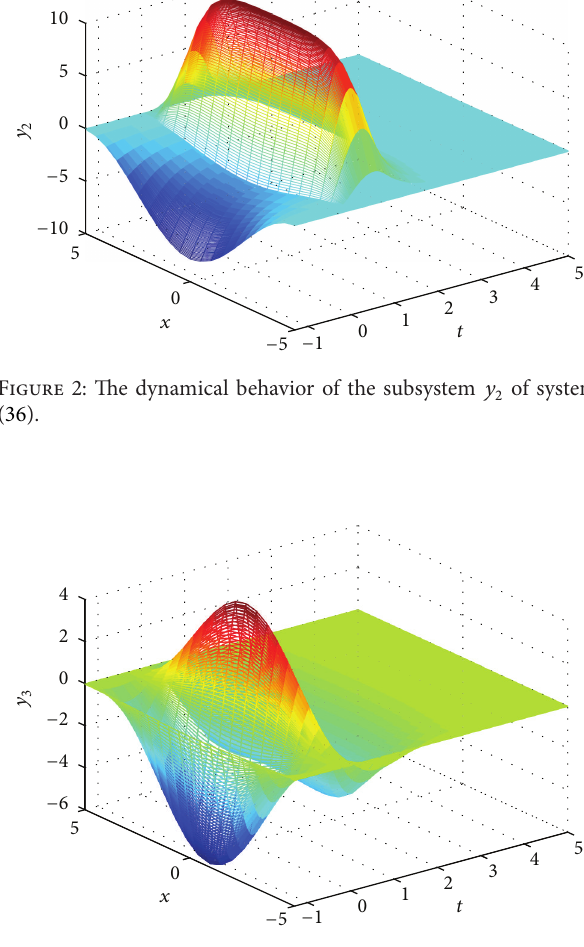
Figure 3: The dynamical behavior of the subsystem 𝑦 3 of system